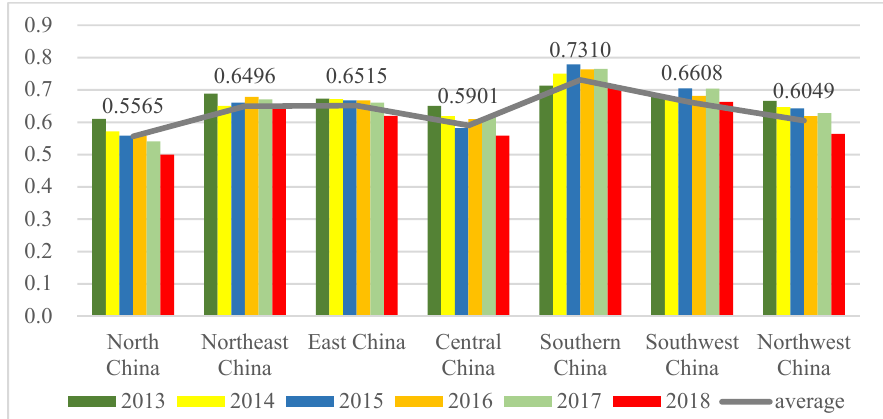
Figure 2. The average level of urban human settlements in the seven regions of China. ArcGIS natural discontinuity method is used to classify data and form five types of human settlements in prefecture-level cities in China: low level, lower level, medium level, high level, and higher level (Figure 3).